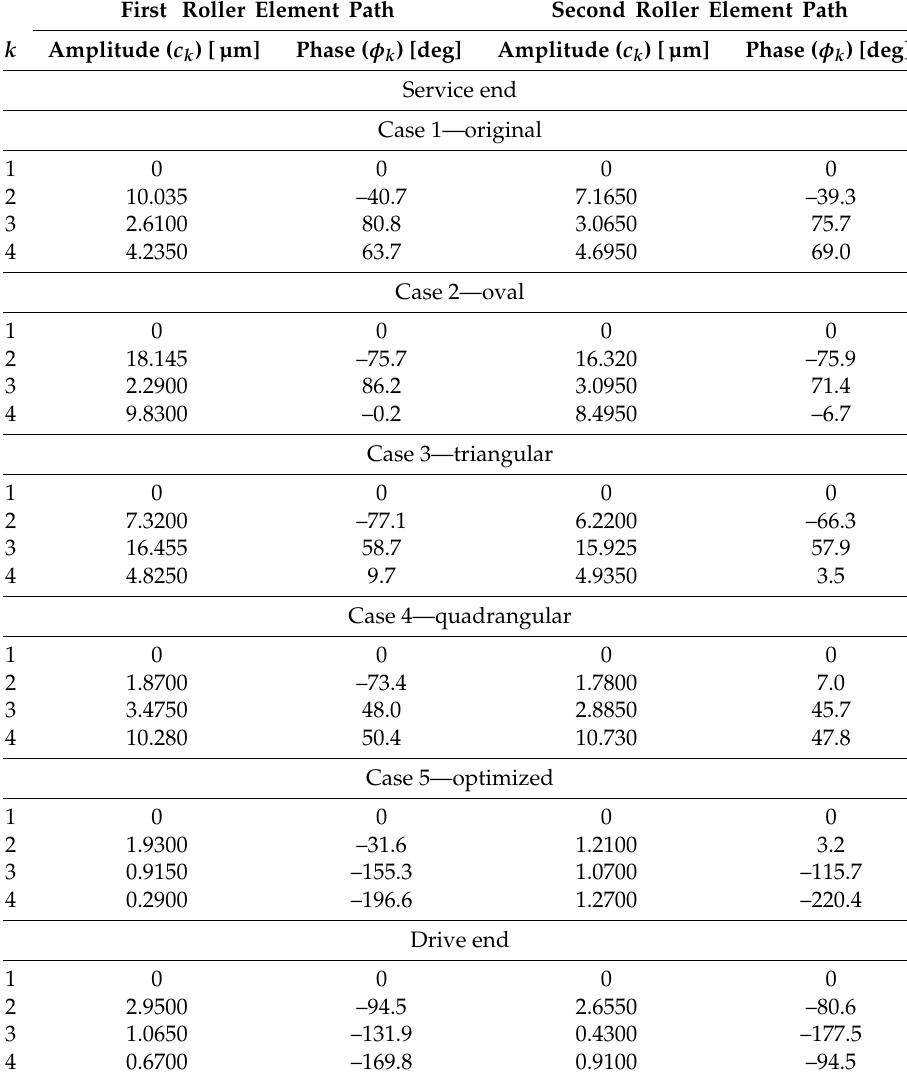
Table 1. Bearing waviness amplitudes used in the simulation